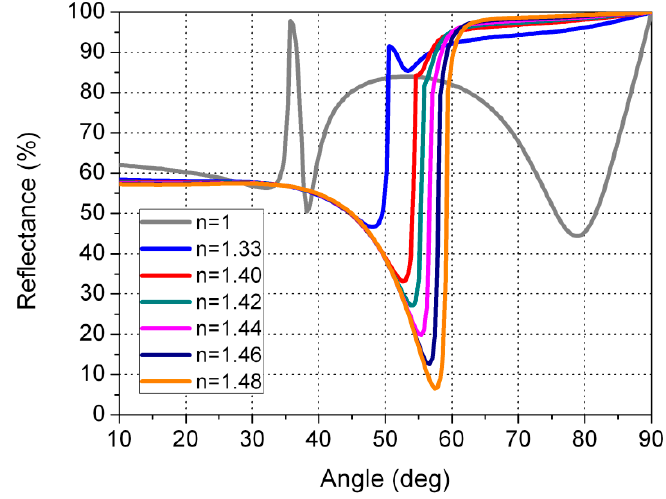
Figure 7. Reflectance curves as a function of the angle of incidence of the light in the prism for a gold layer of 28 nm. The thickness of the dielectric layer of the MgF 2 is 190 nm.